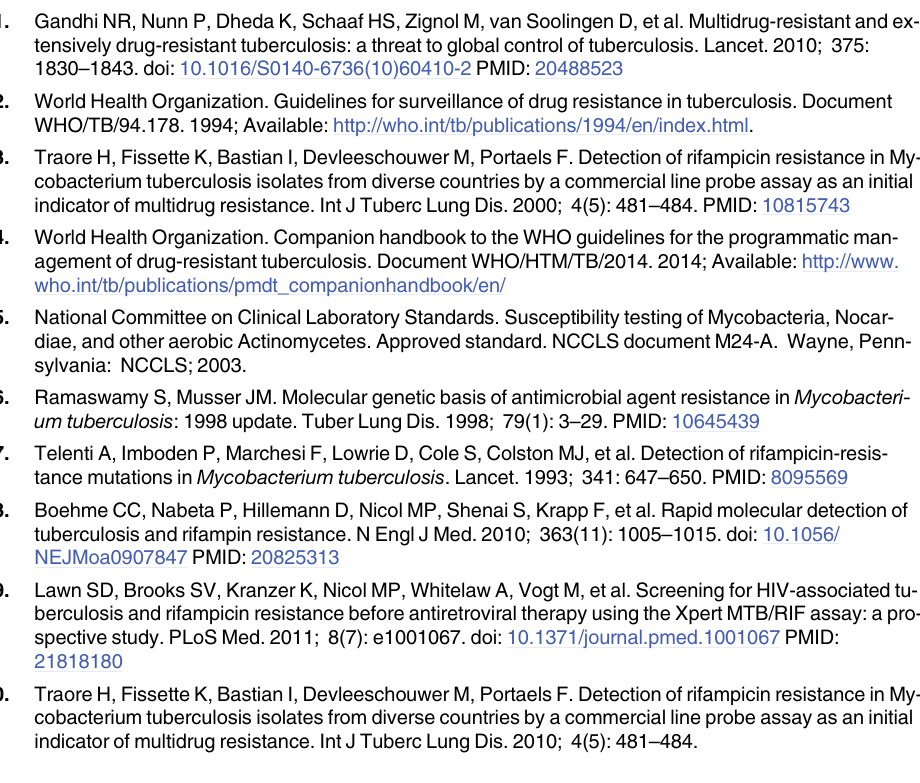
S1 Table. L511P cluster — mutation found in genes linked to resistance to drugs and con- ventional DST results. List of drugs and genes adopted from [35]. Drugs with conventional susceptibility result are shown in